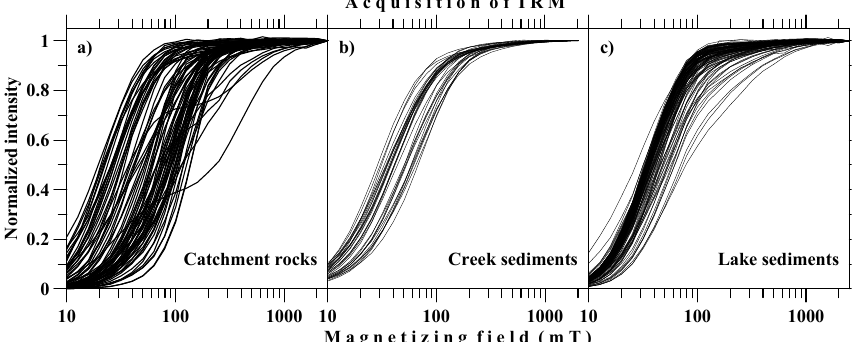
Fig. 10. Normalized acquisition of isothermal remanent magnetization (IRM) with respect to applied magnetic field strength in differ- ent sample types. (a) Catchment rocks gain remanence rapidly in low fields, indicating the presence of multi-domain titanomagnetite. (b) Creek sediments appear more homogenous in their grain size and mineralogy, and most samples are saturated by magnetic field 200mT in strength, which is typical of (titano)magnetite. (c) Similar to catchment rocks, some lake sediment samples indicate the presence of high- coercivity magnetic minerals. Most of the samples are dominated by low-coercivity titanomagnetite, as demonstrated by (near) saturation in fields <